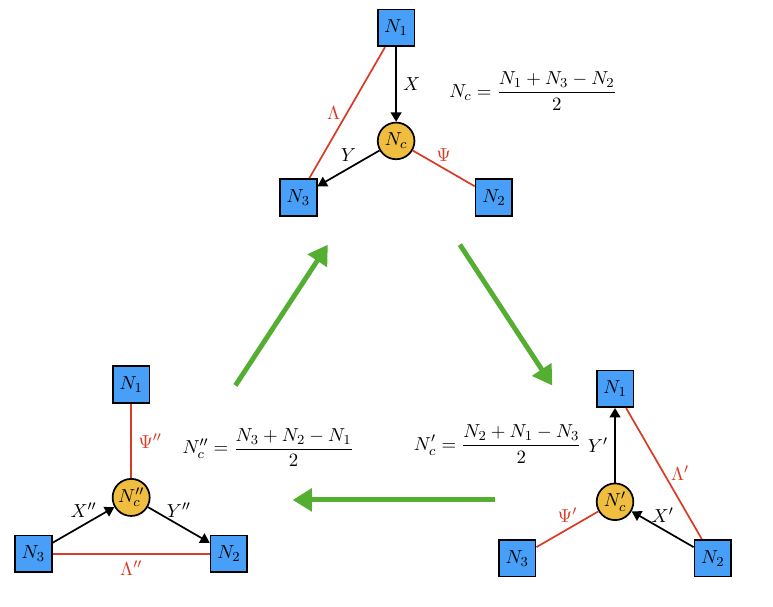
Figure 2 . Triality loop for 2 d N = (0 , 2)